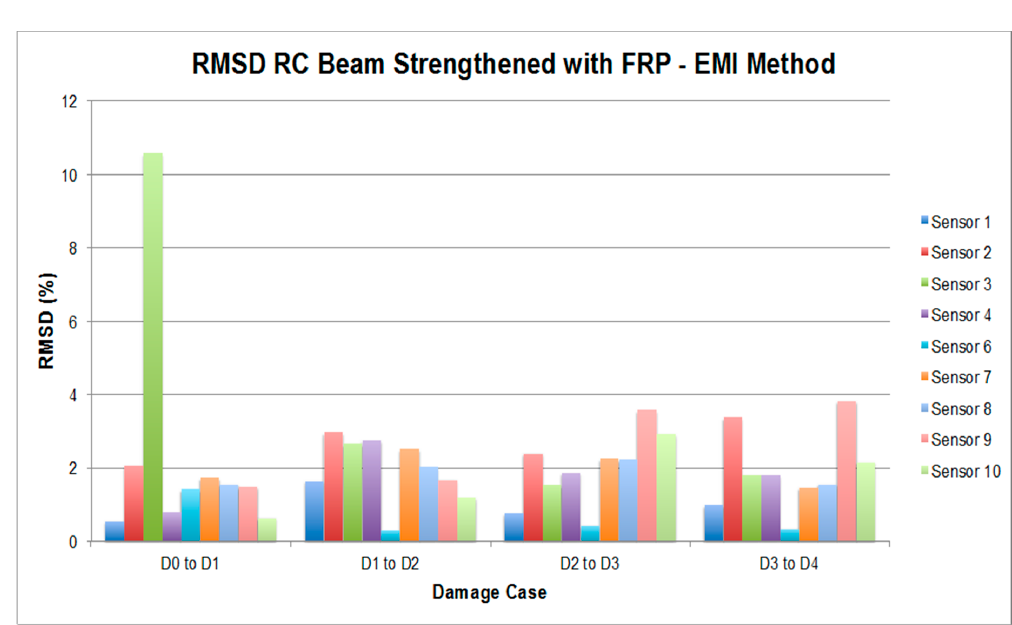
Figure 30. RMSD values for the RC beam corresponding to the EMI